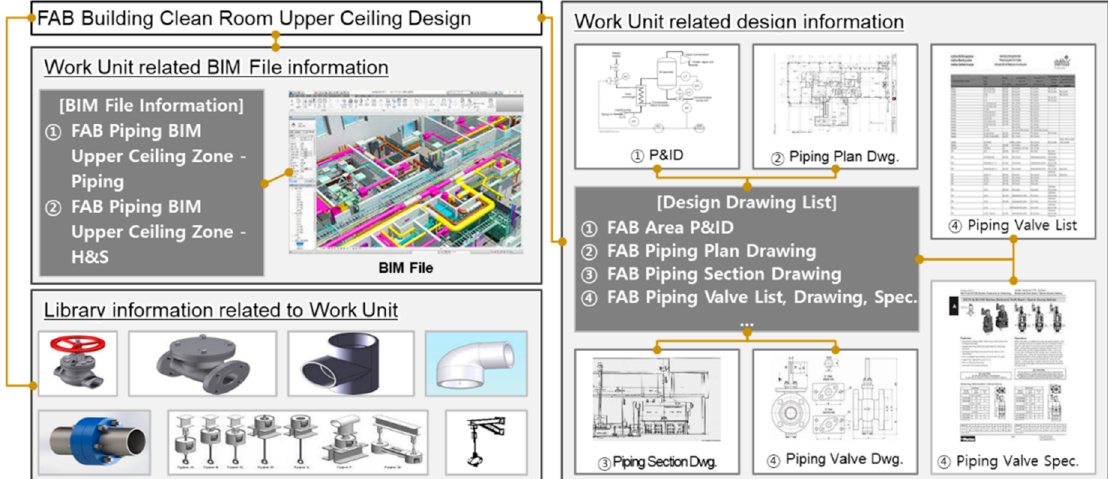
Figure 1. BIM-based FAB project drawing relationship diagram (adapted from [9–11]).